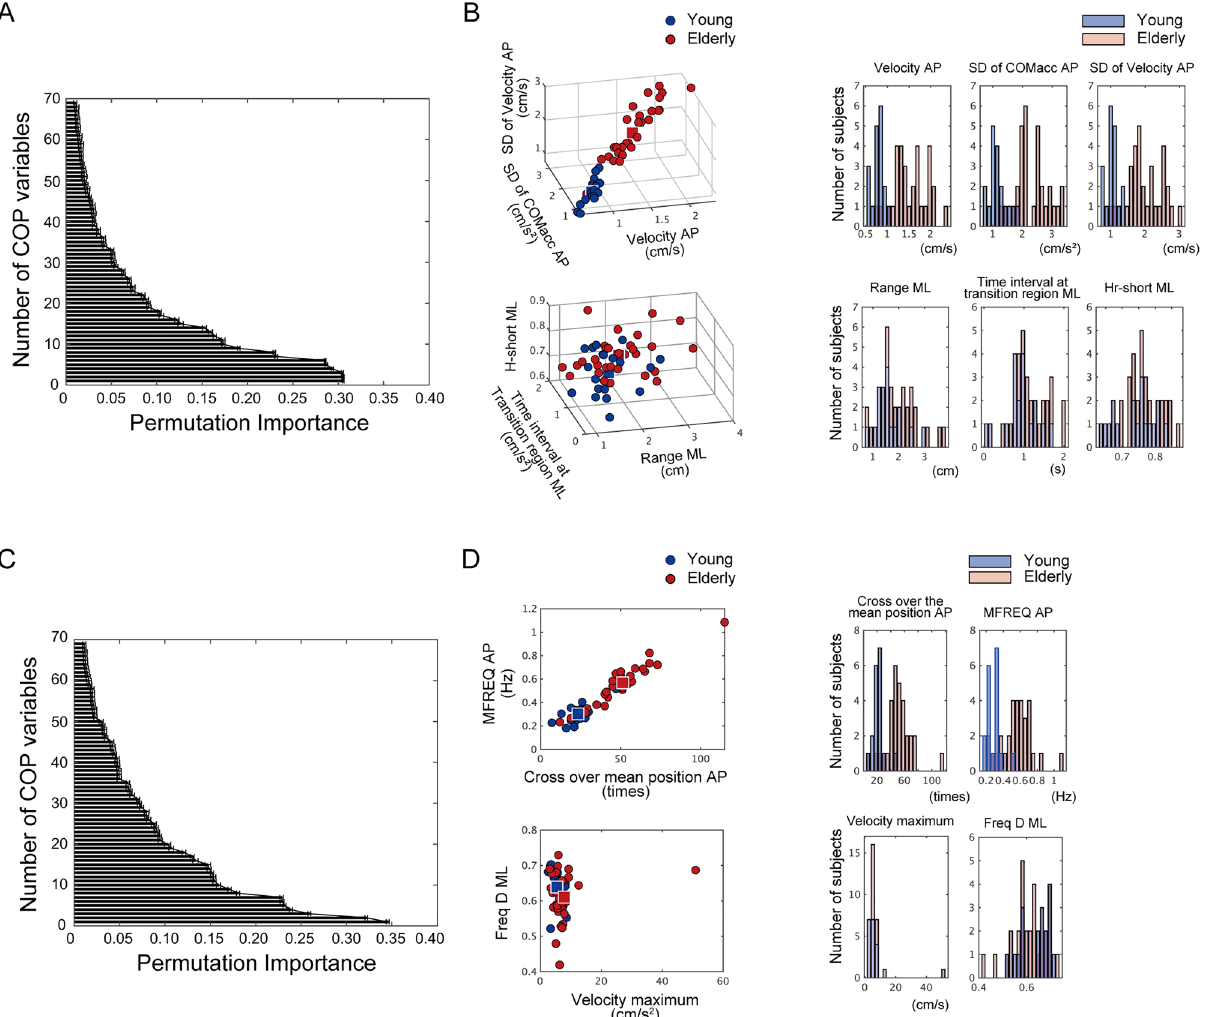
Figure 2. The informative predictors extracted by the random forest in the Foam (upper row) and EC conditions (lower row) for discriminating young and elderly postures. ( A ) Variable importance for the COP indices in the Foam condition. (Standard errors are shown). ( B ) Scatter plots and histograms of the informative and un-informative predictors in the Foam condition (upper row; informative predictors, lower row; un-informative predictors, left; scatter plots, right; histograms). Three informative predictors were extracted in the Foam condition. The same number of uninformative predictors as informative predictors were chosen in the order beginning with the lowest value of the permutation importance. Square symbols in scatter plots represent the average values. ( C ) Variable importance for the COP indices in the EC condition. ( D ) Scatter plots and histograms of the informative and uninformative indices in the EC condition (upper row; informative indices, lower row; un-informative indices). Two informative and uninformative predictors were plotted in the Foam